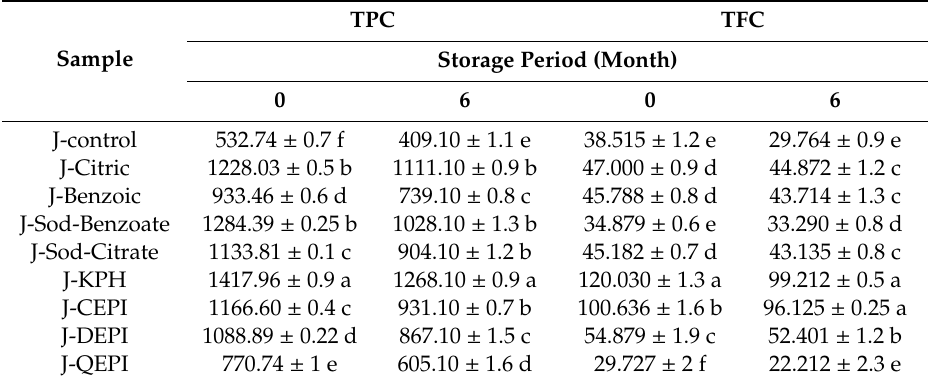
Table 2. Changes in total phenolic compounds and flavonoids during period